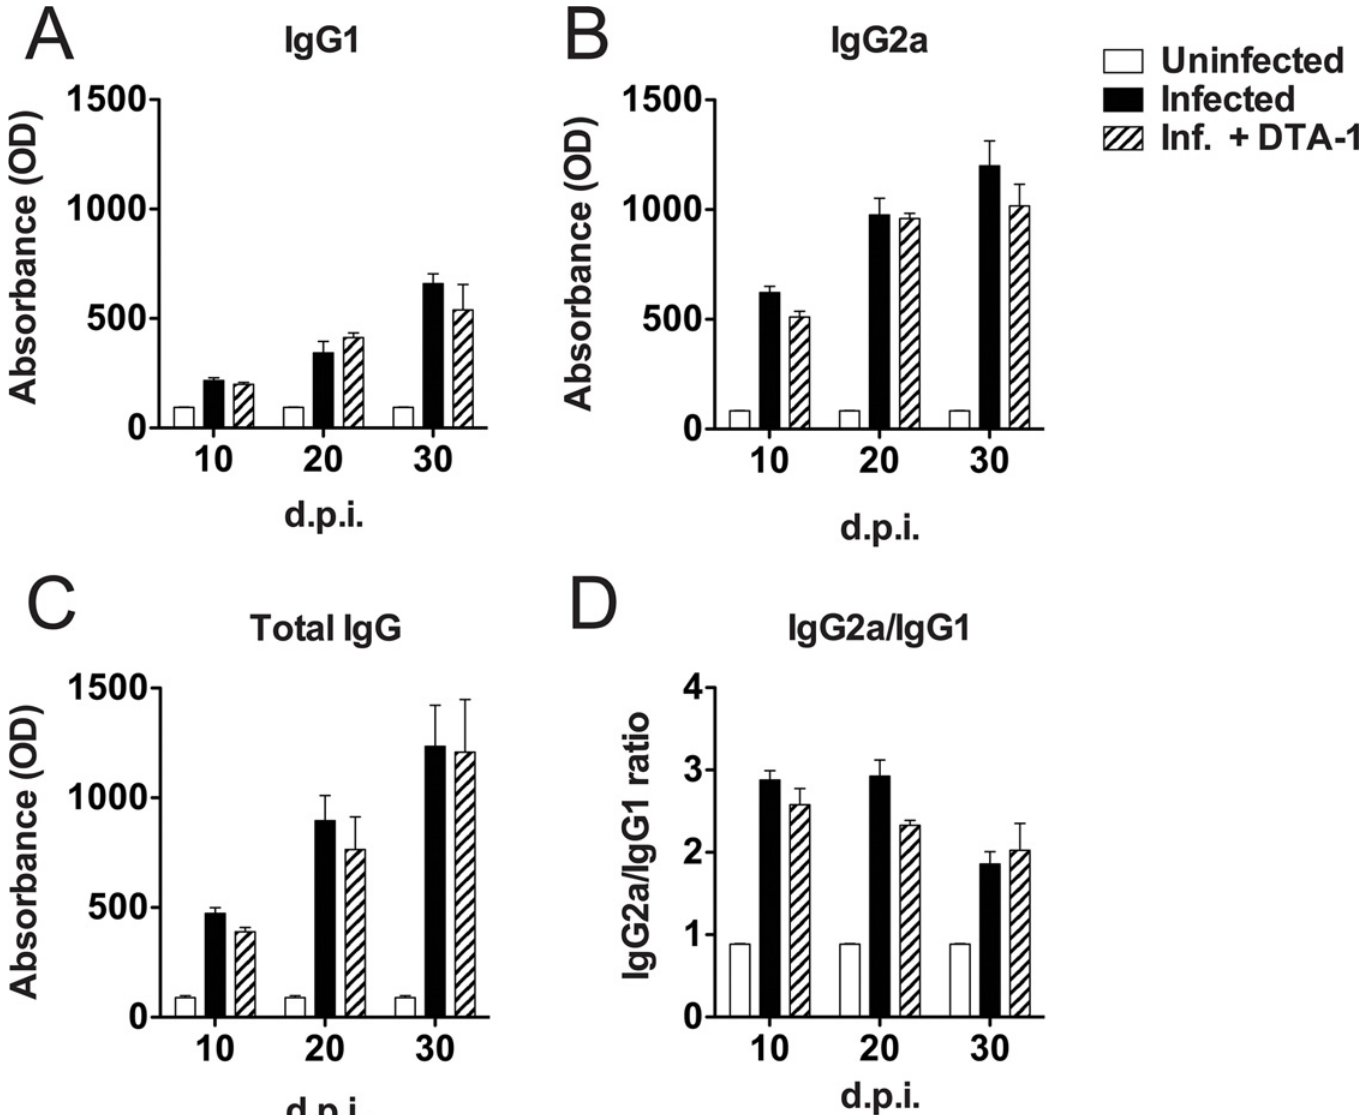
Fig 6. GITR activation does not alter antibody production. C57BL/6 mice were treated or not with 500 μ g of DTA-1 one day before experimental infection. In the control group, PBS was administered. Infection was performed with 20 cysts injected i.p. A blood sample was collected on days 10, 20 and 30 after infection. Levels of IgG1 (A), IgG2a (B), Total IgG (C) and IgG2a/IgG1 ratio (D) were assessed by ELISA. Error bars indicate mean +/- SEM (n =